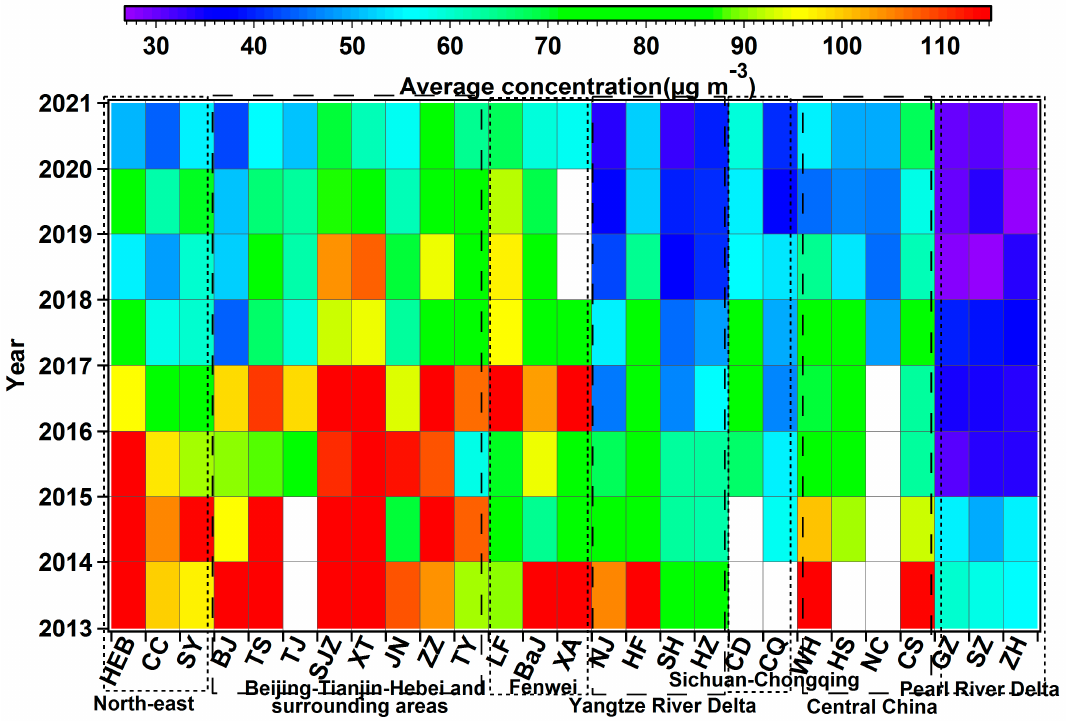
Figure 2. Statistics of PM 2.5 mean values of 7 regional representative stations in central and eastern China from 2013 to 2020 in autumn and winter.